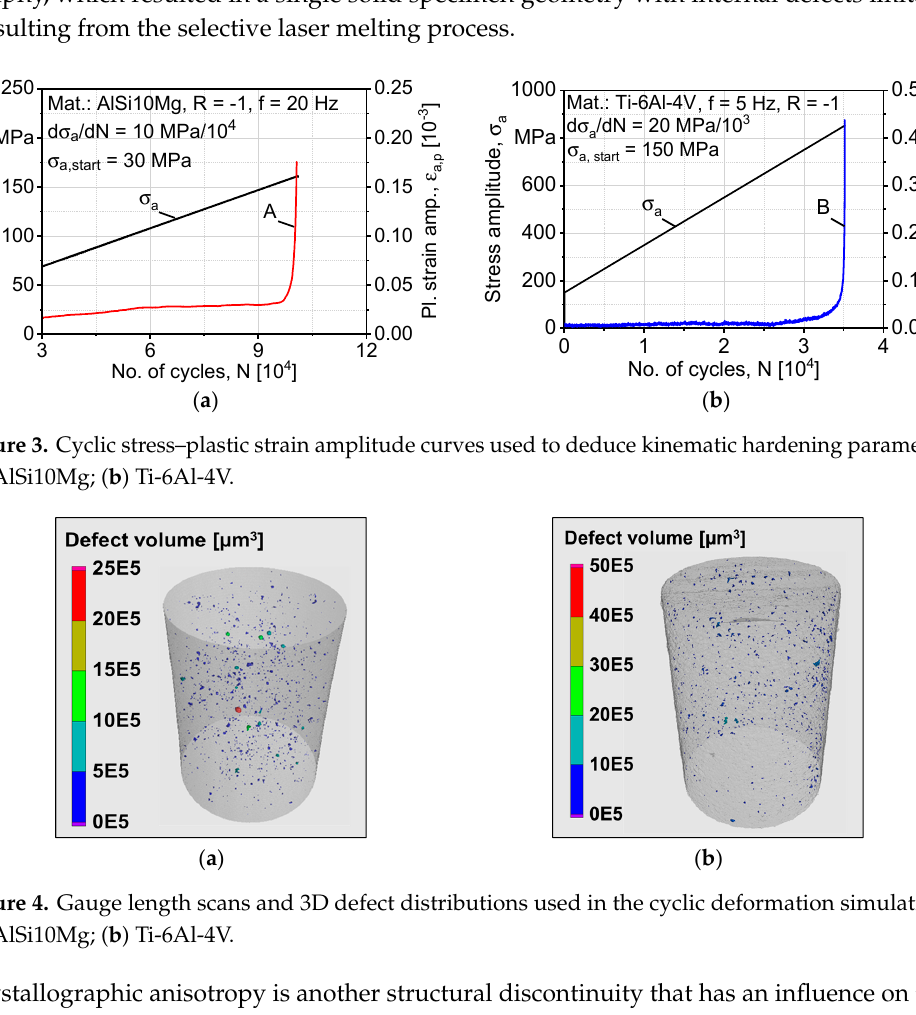
( d ) Figure 2. Quasi-static stress–strain curves used to deduce isotropic hardening parameters: ( a )